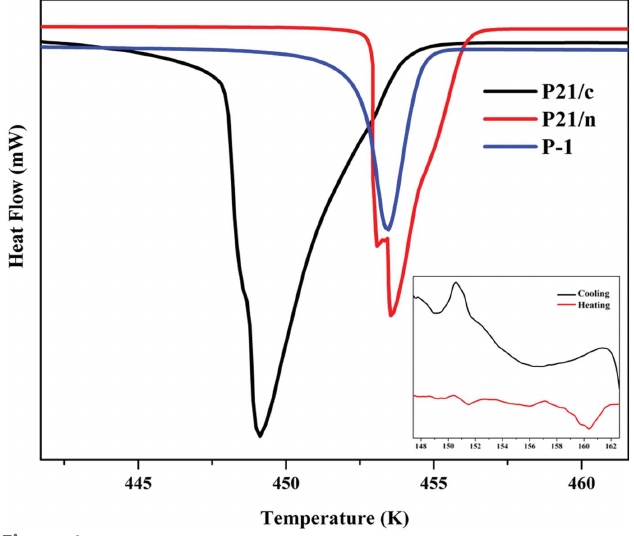
Figure 4 Thermodynamic (DSC) profile of forms II , III and V . Low temperature reversible III ! IV phase transition (inset).